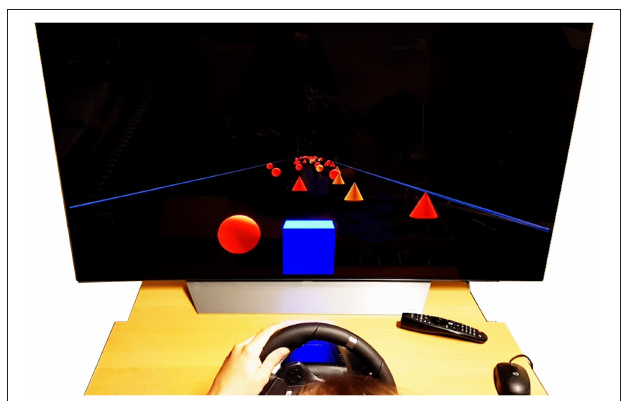
FIGURE 1 | The high-speed steering task. The participant steers the blue cube to avoid conical/spherical obstacles on the track, which is bounded to each side by dark blue parallel lines. The game was designed to continually adapt the difficulty level (speed) to the participant’s skill (obstacle collisions). Such balance is considered one of the key antecedents of